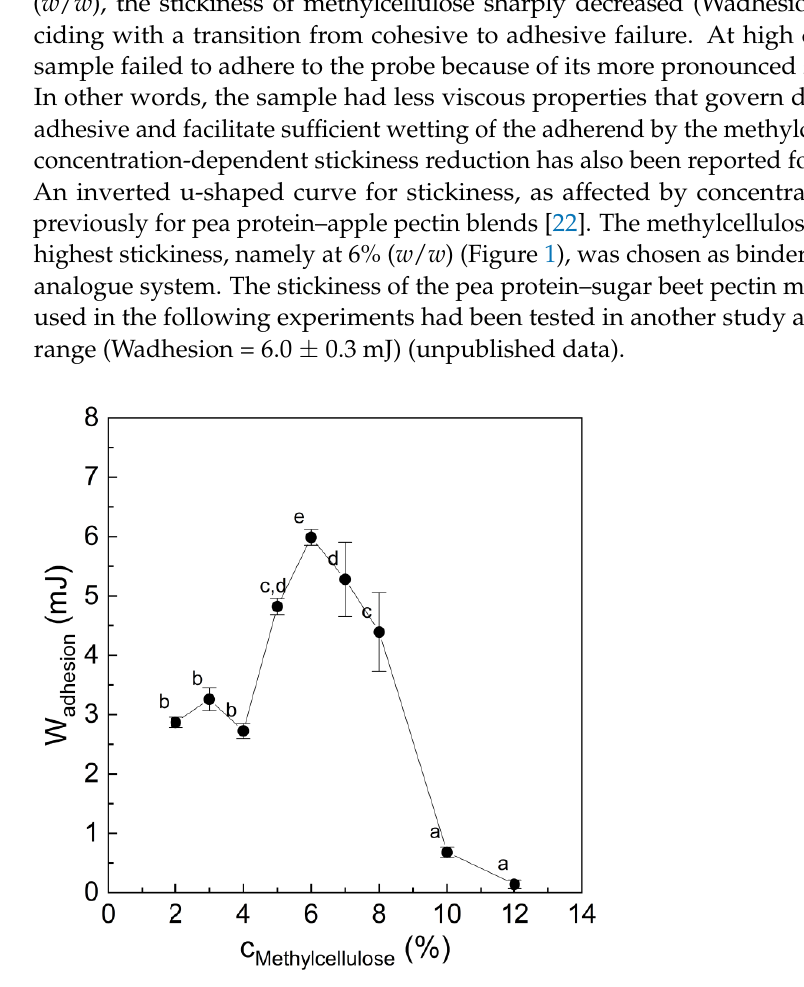
Figure 1. Stickiness of methylcellulose hydrogels during probe tack test, as affected by concentration. Data points with different letters denote a statistical difference ( p < 0.05)